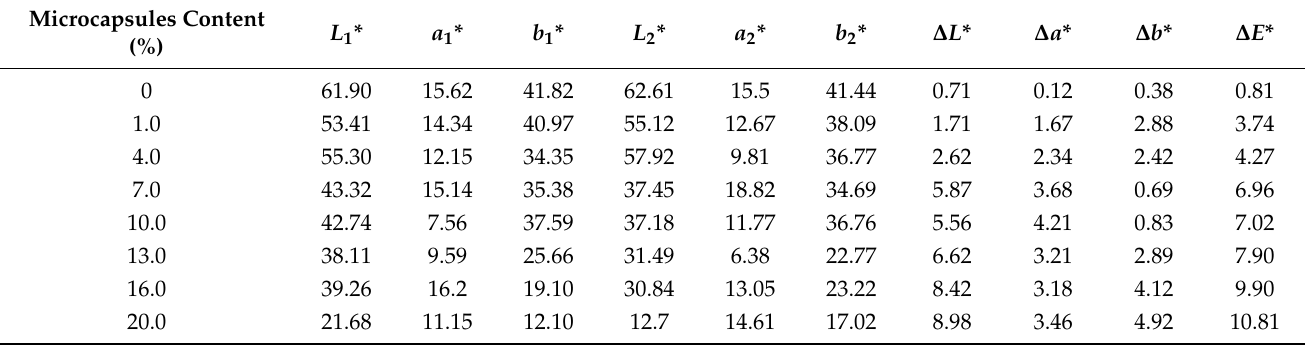
Table 4. Chromaticity value and color difference of the coatings with different microcapsule